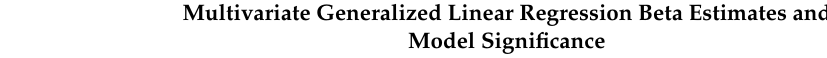
Table 7. Multivariate GLM for the effect of EARN on